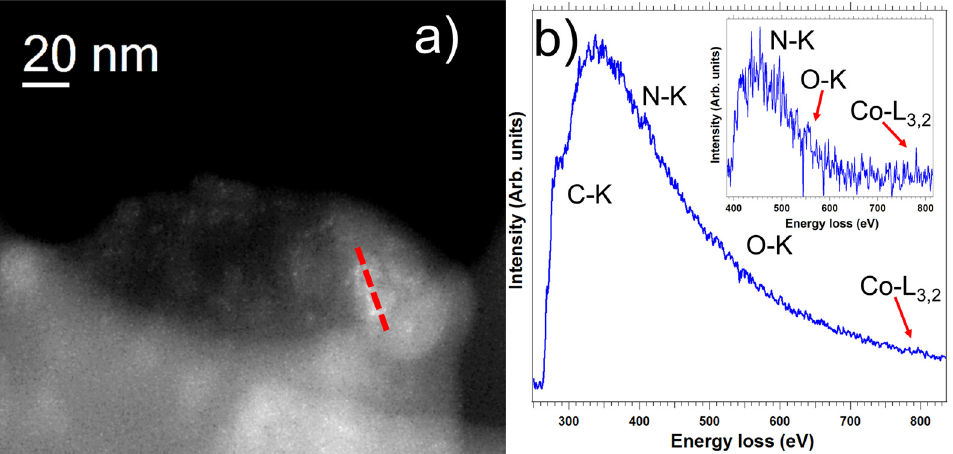
Figure 6. ( a ) HAADF-STEM micrograph of [Co]-pyr-graphene recorded on one graphene flake. An EELS spectrum-line has been acquired on the red marked line. ( b ) The EEL spectrum corresponds to the sum of 20 EEL spectra recorded in the red line. The C-K, N-K, O-K and Co-L 3,2 edges are clearly observed.